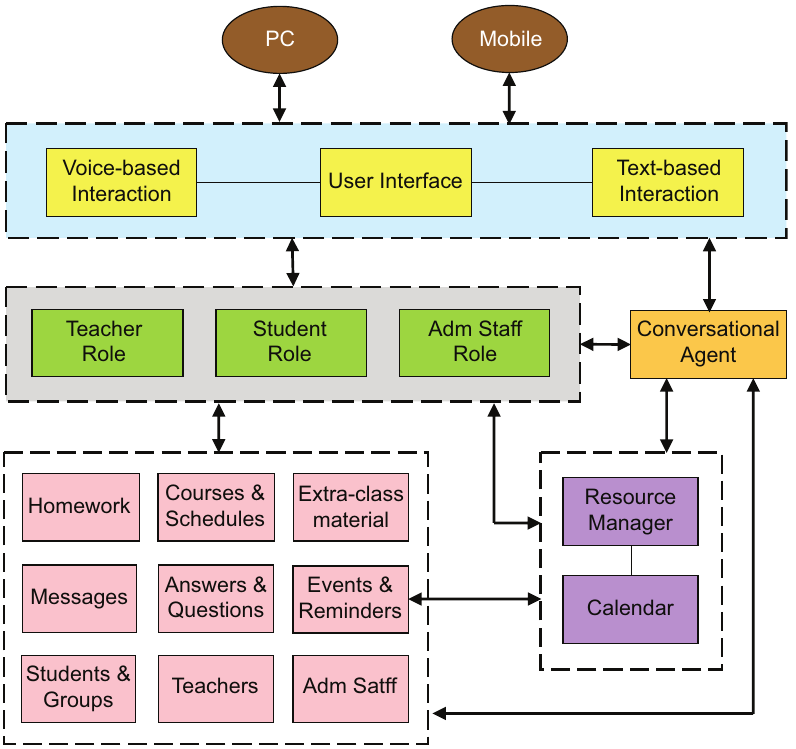
Figure 1. A model for a chatbot assisting the teaching and learning process in middle